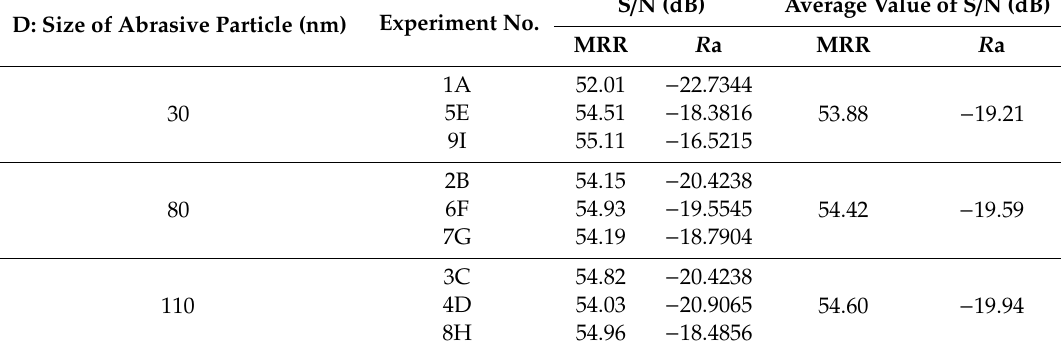
Table 6. Average value of S / N of size of abrasive